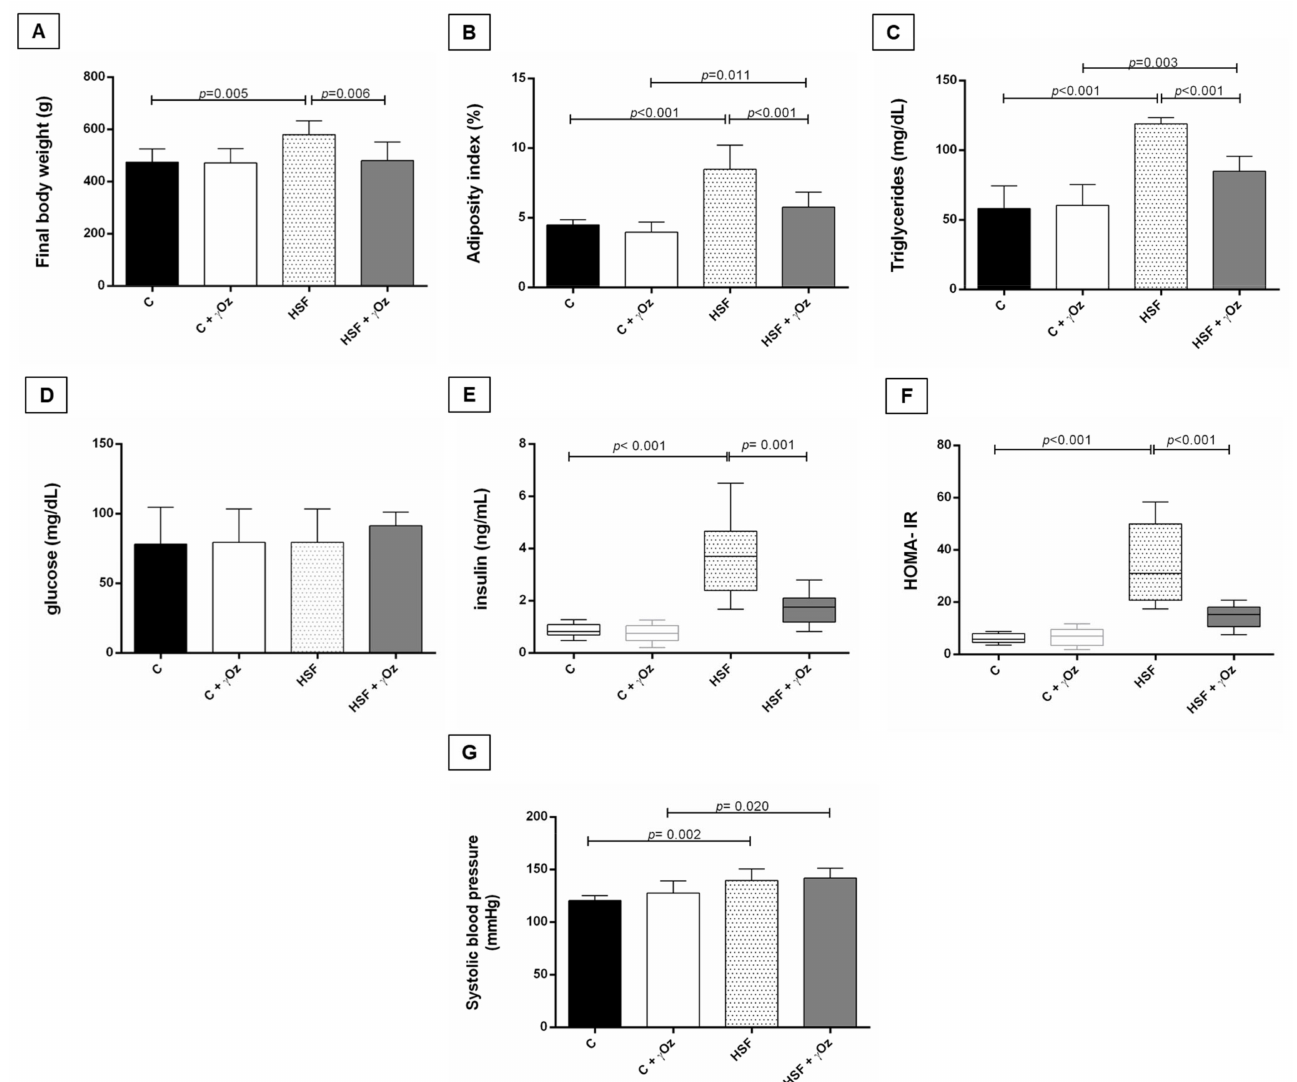
Figure 3. Metabolic syndrome parameters. ( A ) Final body weight (g); ( B ) Adiposity Index (%); ( C ) Triglycerides (mg/dL); ( D ) Glucose (md/dL); ( E ) Insulin (ng/mL); ( F ) HOMA-IR; ( G ) Systolic blood pressure (mmHg). Comparison by two-way ANOVA followed by Tukey or Kruskal–Wallis test. p < 0.05 as